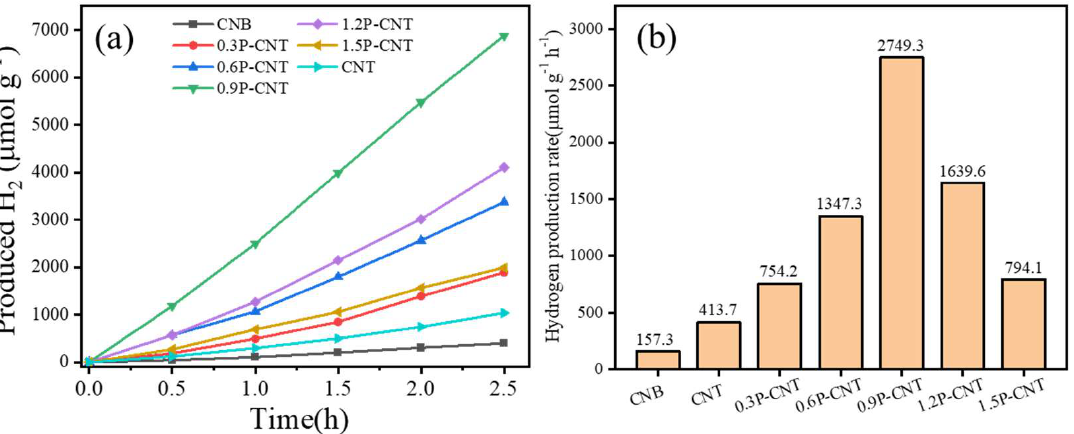
Figure 8. The photocurrent ( a ) and electrochemical impedance spectra ( b ) of the CNB, 0.3P-CNT, 0.6P-CNT, 0.9P-CNT, 1.2P-CNT, and 1.5P-CNT samples.